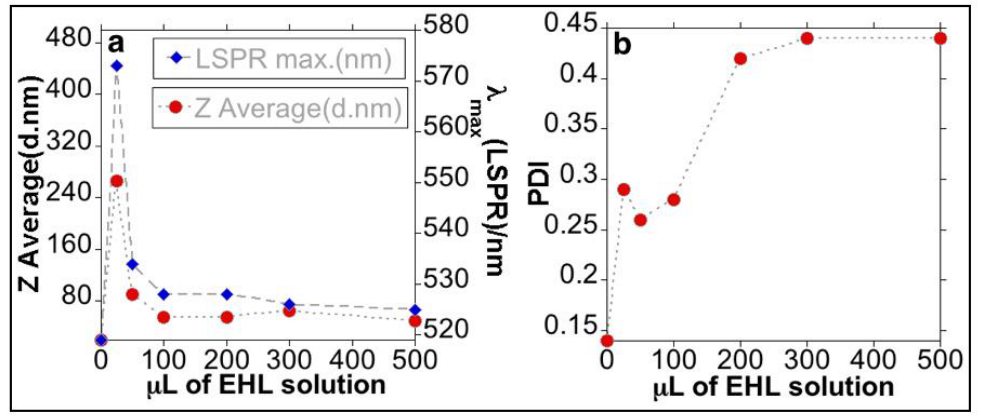
Figure 3. ( a ) Z-average (red dot) and LSPR (Localized Surface Plasmon Resonance) maximum (blue dot) and ( b ) PDI (polydispersity Index) of the AuNPs@EHL obtained as a function of EHL amounts added.